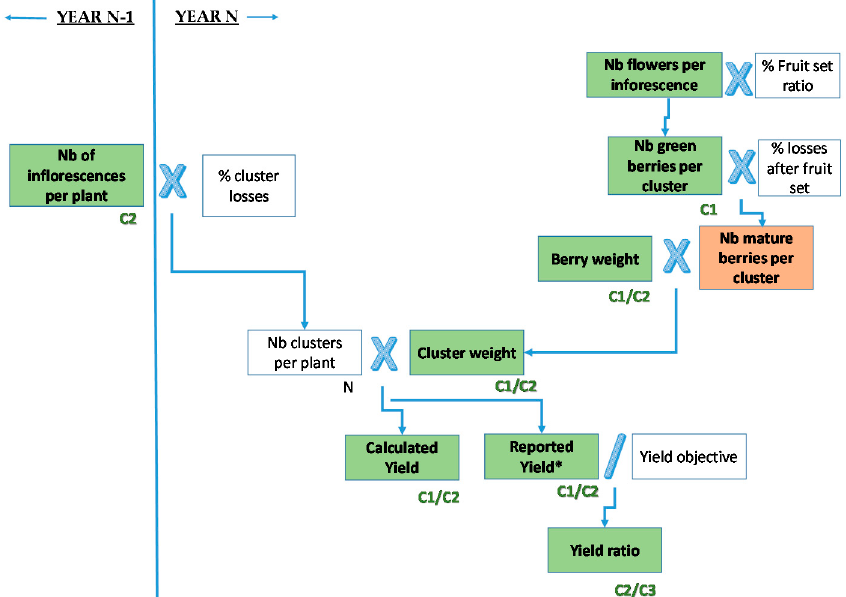
Figure 9. Synthesis of the analysis performed in this study, showing the various yield components involved in the yield elaboration process. White boxes represent yield components that were not measured. Orange boxes represent the yield components not impacted by conversion. Green boxes show those statistically impacted by conversion. The year of impact is also shown in green letters next to the relevant boxes. Nb: Numbers. * For threshold of significance of 10%.